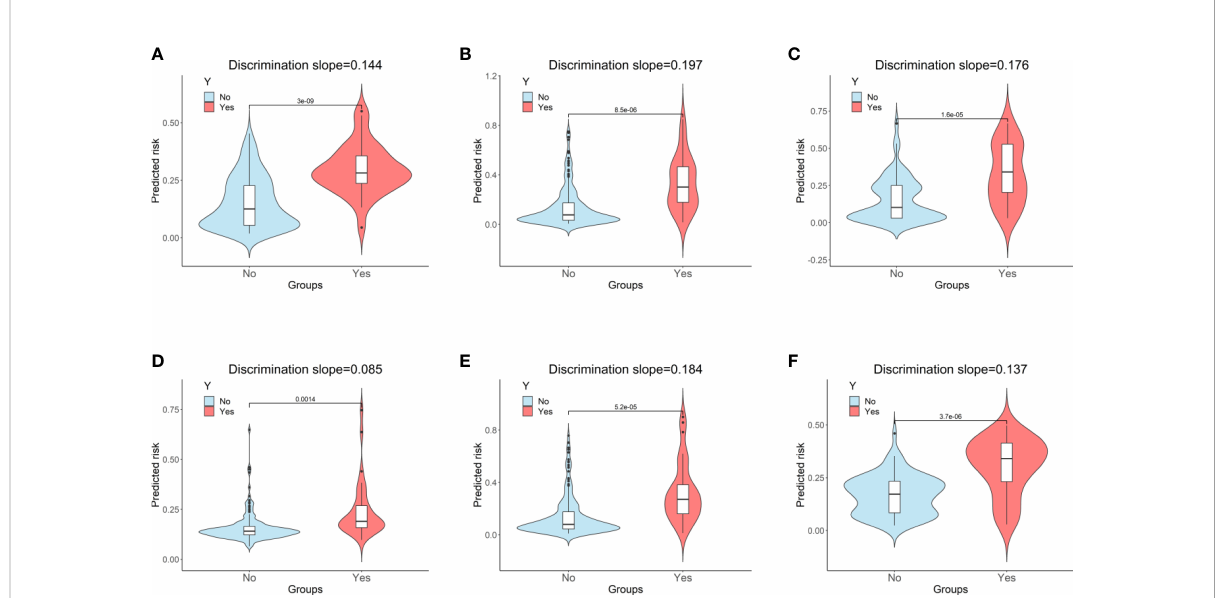
FIGURE 5 Violin plots of predicted probability with (red) and without (sky blue) the outcome. (A) Random Forest for internal validation; (B) Gradient Boosting Machine; (C) Decision Tree; (D) Support Vector Machine; (E) Logistic Regression; (F) Random Forest for external validation. “ Y ” indicates the outcome; “ No ” indicates patients without persistent critical illness; “ Yes ” indicates patients with persistent critical illness.